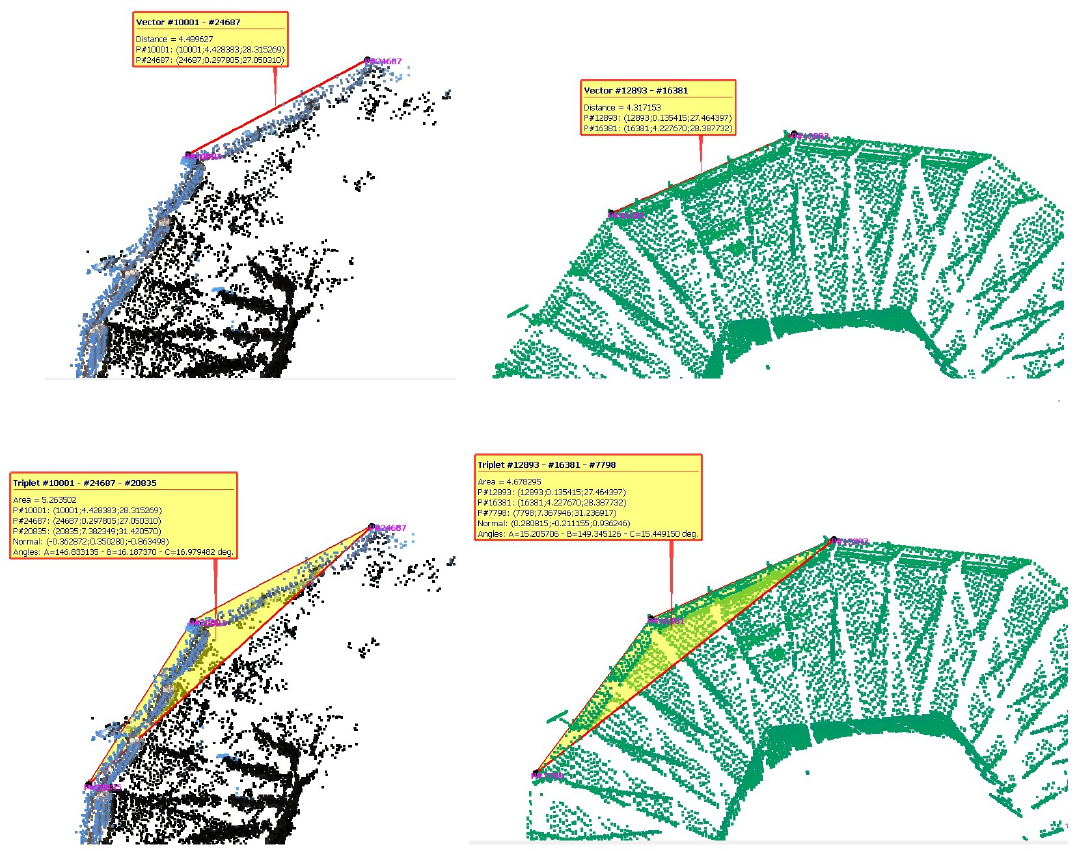
Figure 4: Top; measuring the distance between the same reference points based on iPhone and laser scanning point clouds respectively. Bottom; measuring the angle between two edges based on iPhone and laser scanning point clouds